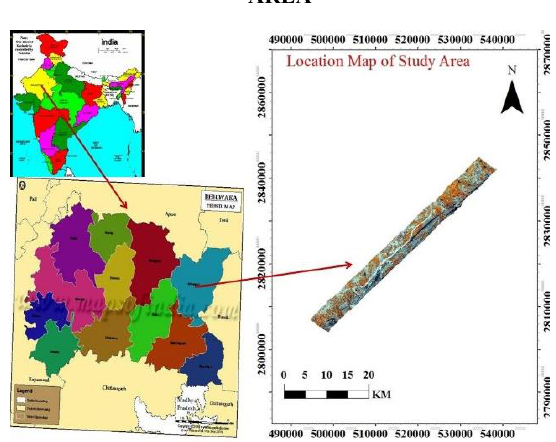
Figure 1. Location map of the study